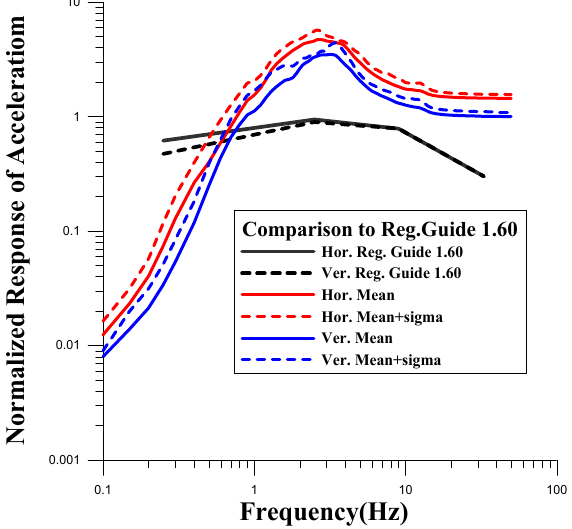
Comparison to Reg.Guide 1.60 Hor. Reg. Guide 1.60